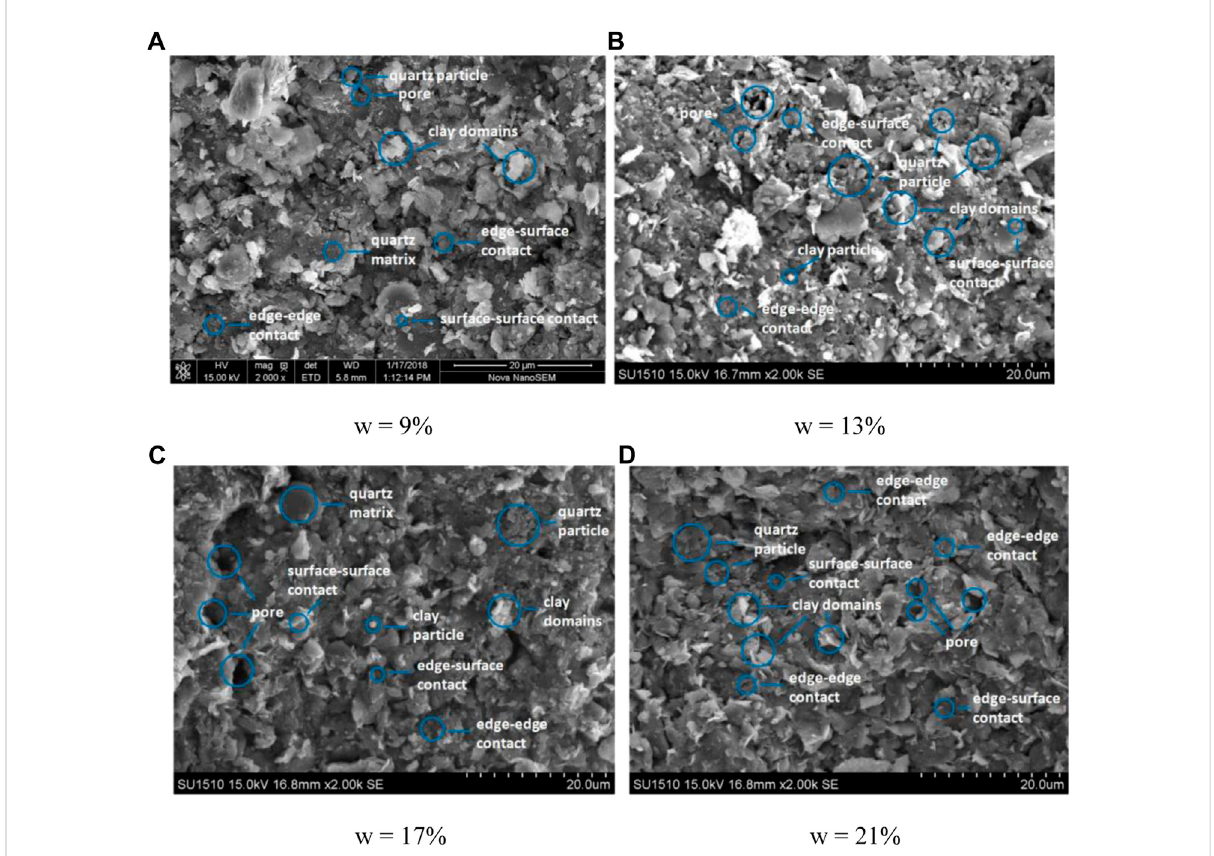
FIGURE 7 The four DWC microcosmic structures of the CBSwith the different moisture contents. (A) w = 9% (B) w = 13% (C) w = 17% (D) w =